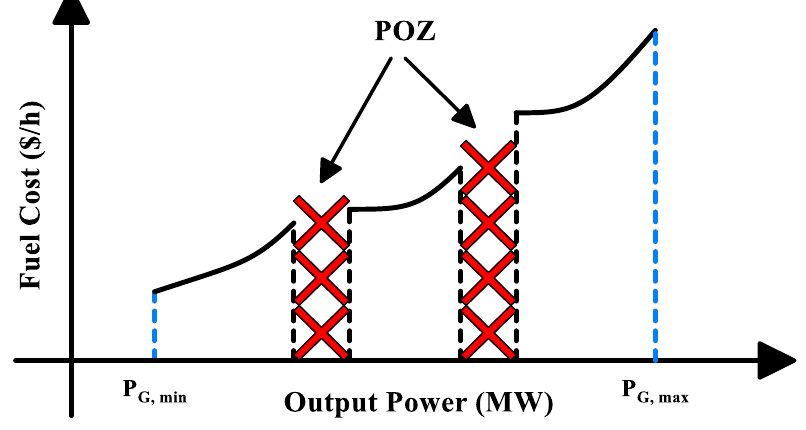
Figure 7. Cost function with disjoint operating zones.